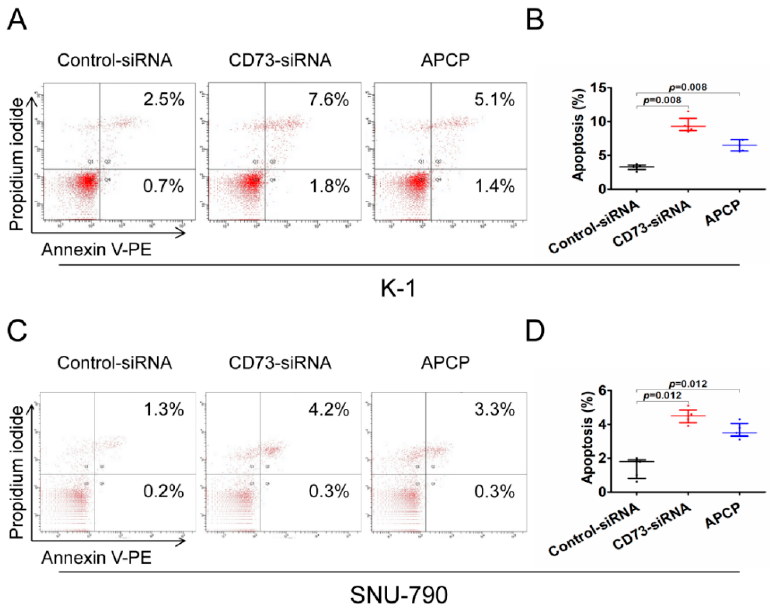
Figure 4. Analysis of apoptosis by flow ‐ cytometry. Downregulation of CD73 expression promotes apoptosis of K ‐ 1 cells ( A , B ) and SNU ‐ 790 cells ( C , D ). Downregulation of CD73 was performed